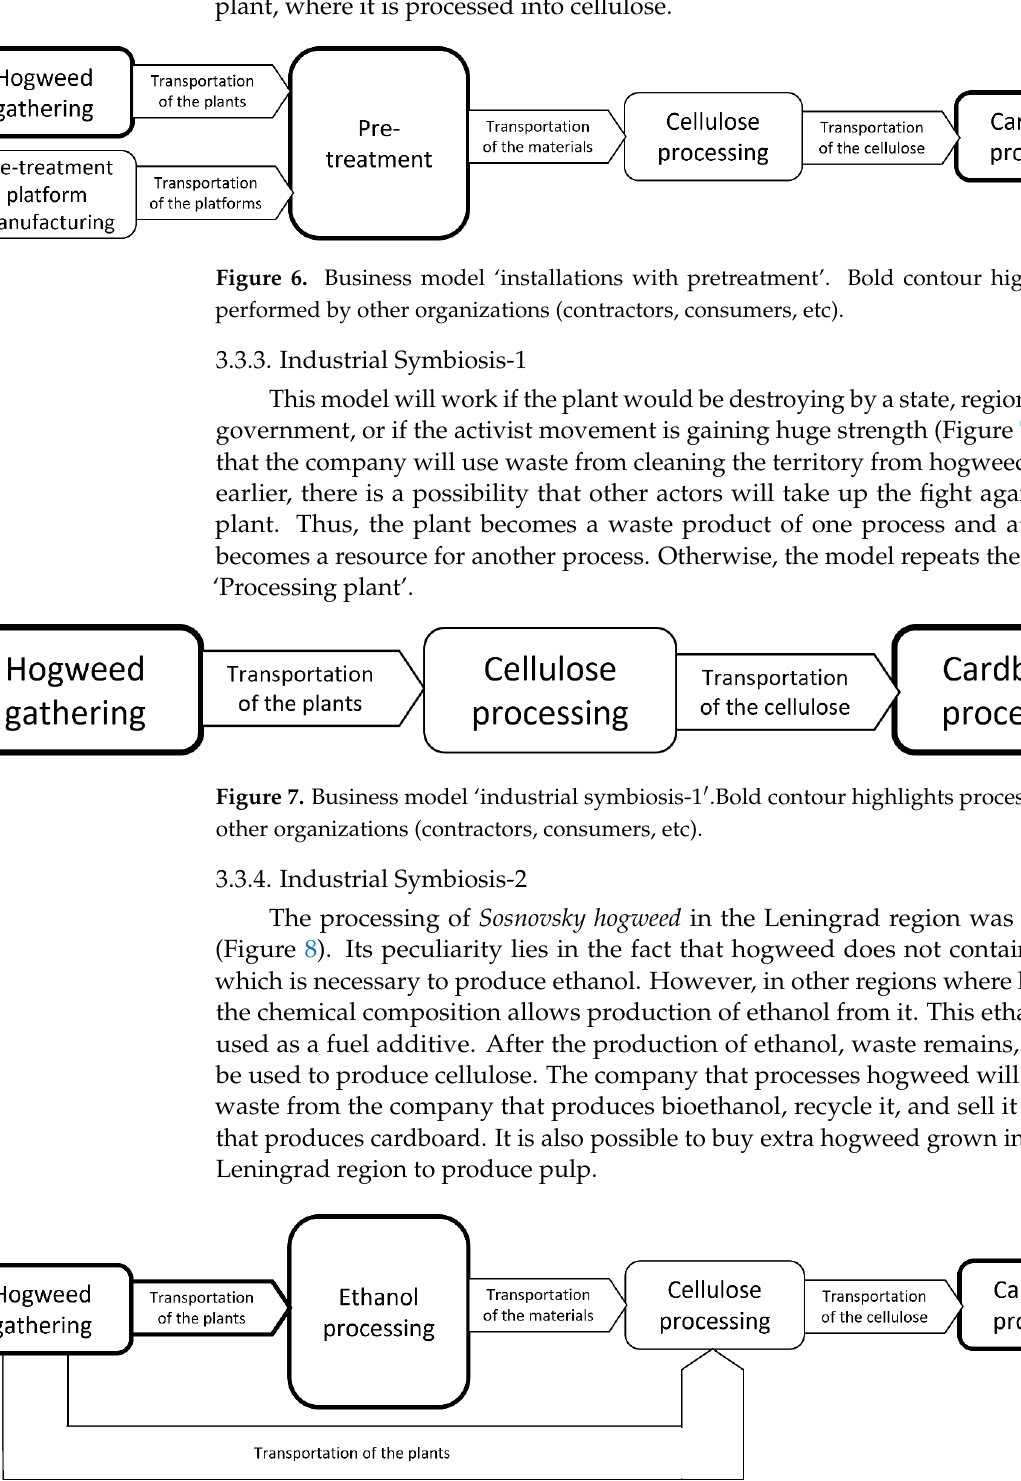
Figure 8. Business model ‘ industrial symbiosis-2 ’ . Bold contour highlights processes performed by other organizations (contractors, consumers, etc.).